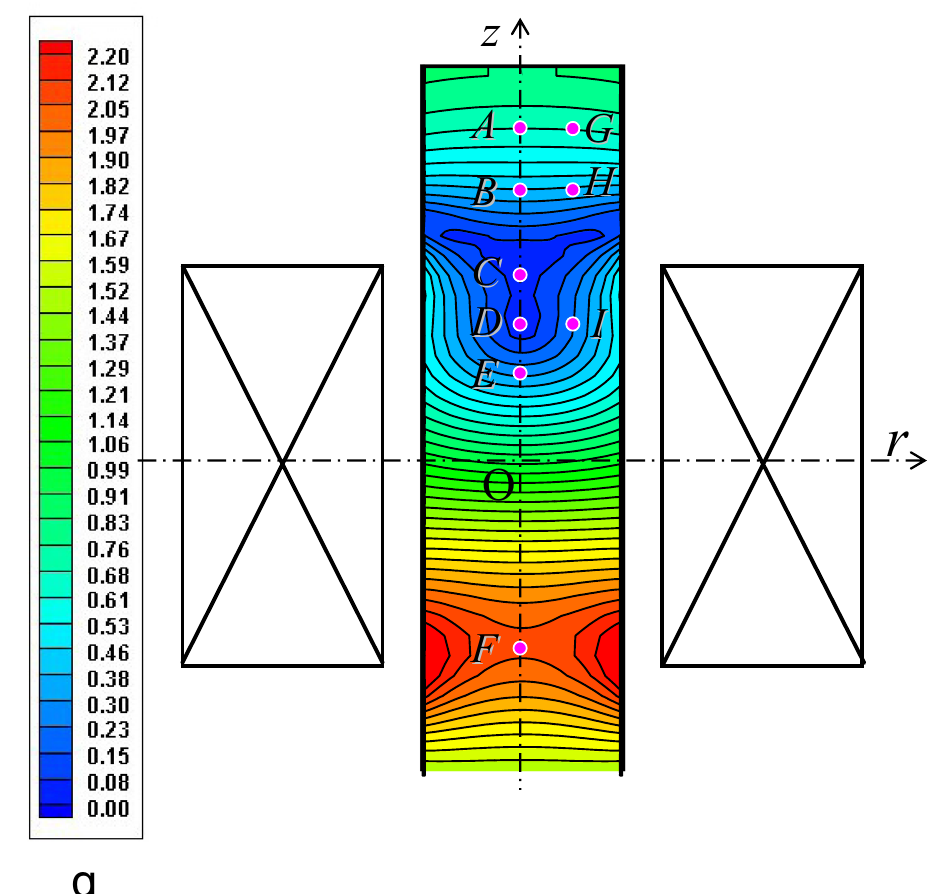
Figure 1. The computational isothermal distribution of the magnitude of the magnetic force. Points A to I are representative points, and C is the point of maximum magnetic force (MMF). The magnetic force magnitude is computed so that f z becomes zero at the MMF point. The blue isothermal distribution corresponds to a weak gravity environment, and the red distribution corresponds to a hypergravity environment. The hourglass-shaped curves near C indicate that the MF z becomes weak, whereas the MF r is